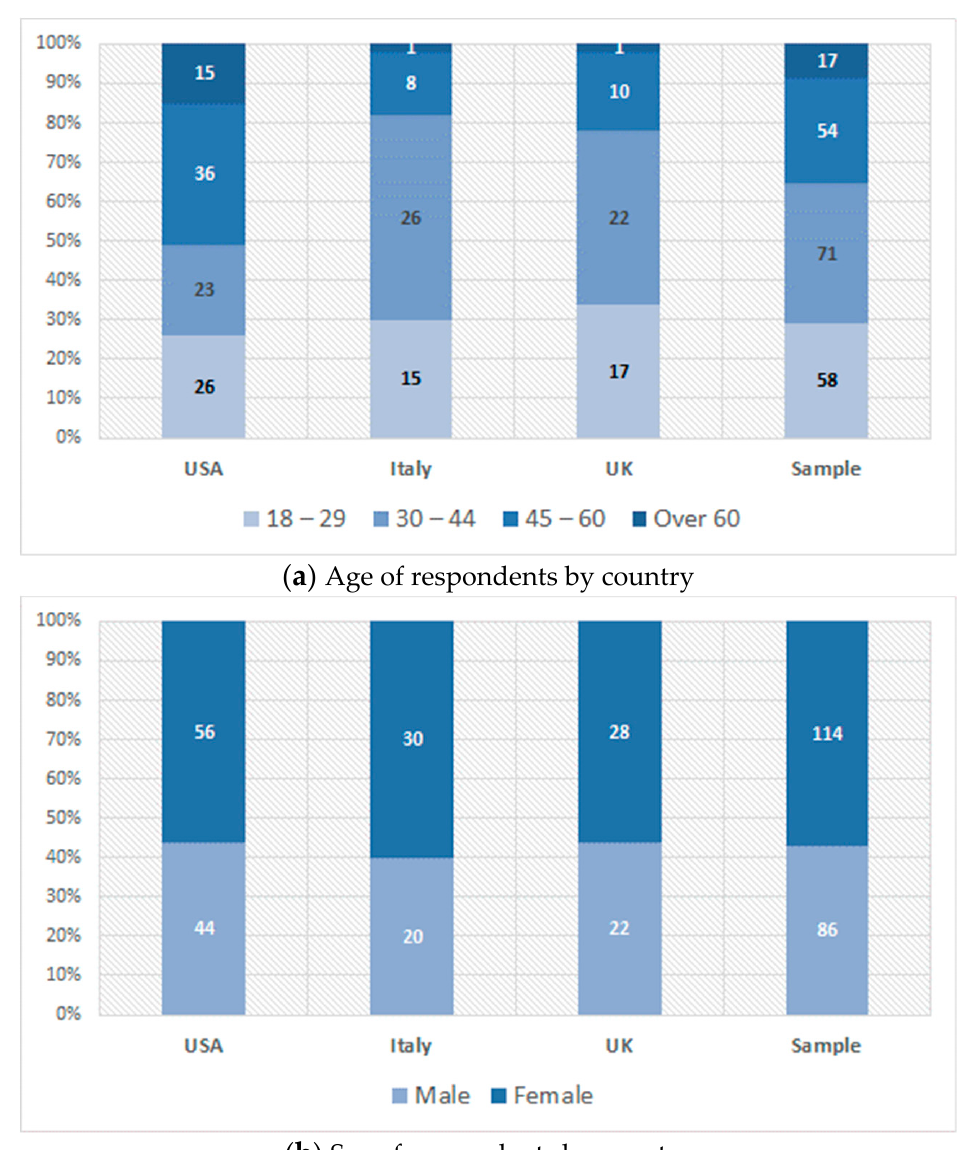
Figure 1. Composition of the sample of respondents.